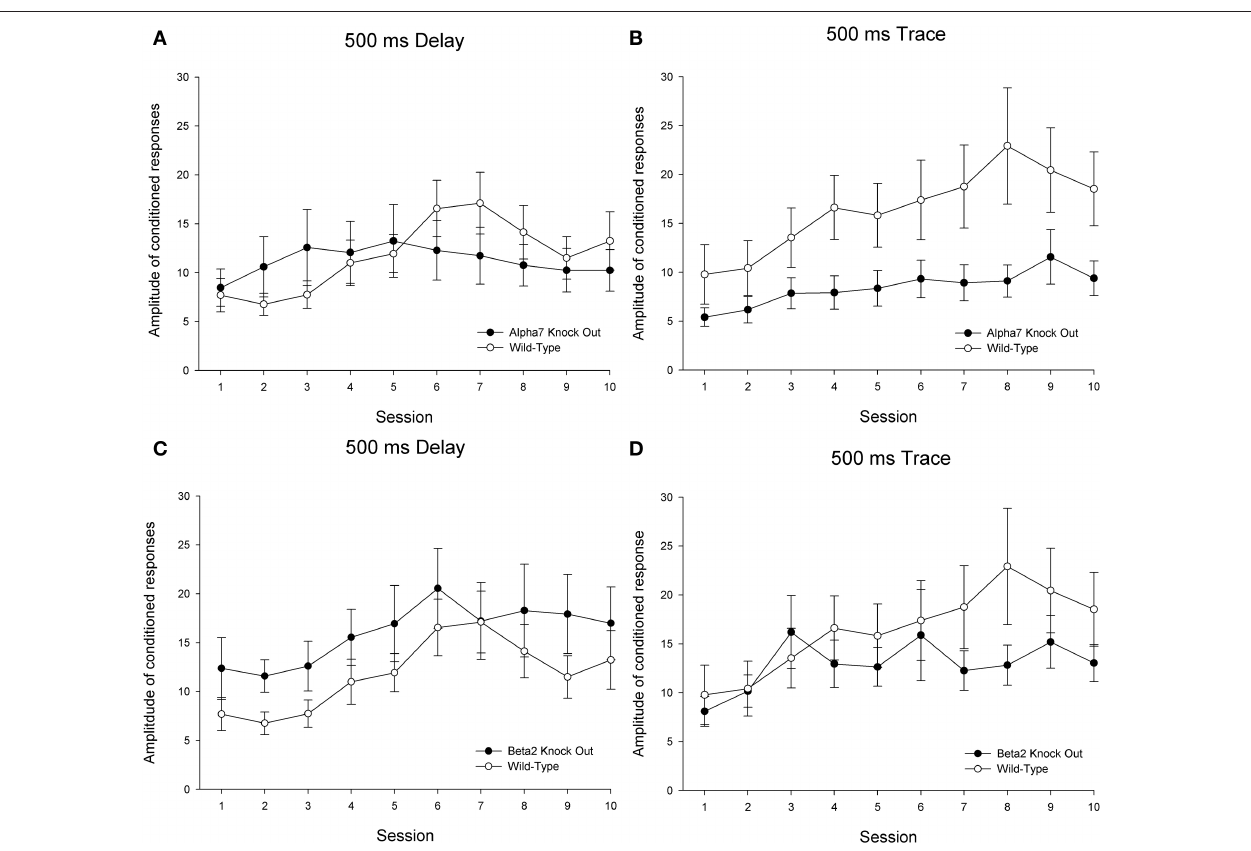
trials. Performance in the 90 paired trials/session is shown here. Delay eyeblink conditioning is depicted on the left side and trace eyeblink conditioning is shown on the right. Comparisons between wild-type controls and α 7 KOs are shown on the top (A,B) panels, while comparisons between wild-type controls and β 2 KOs are shown across the bottom (C,D) panels. The error bars indicate standard error of the